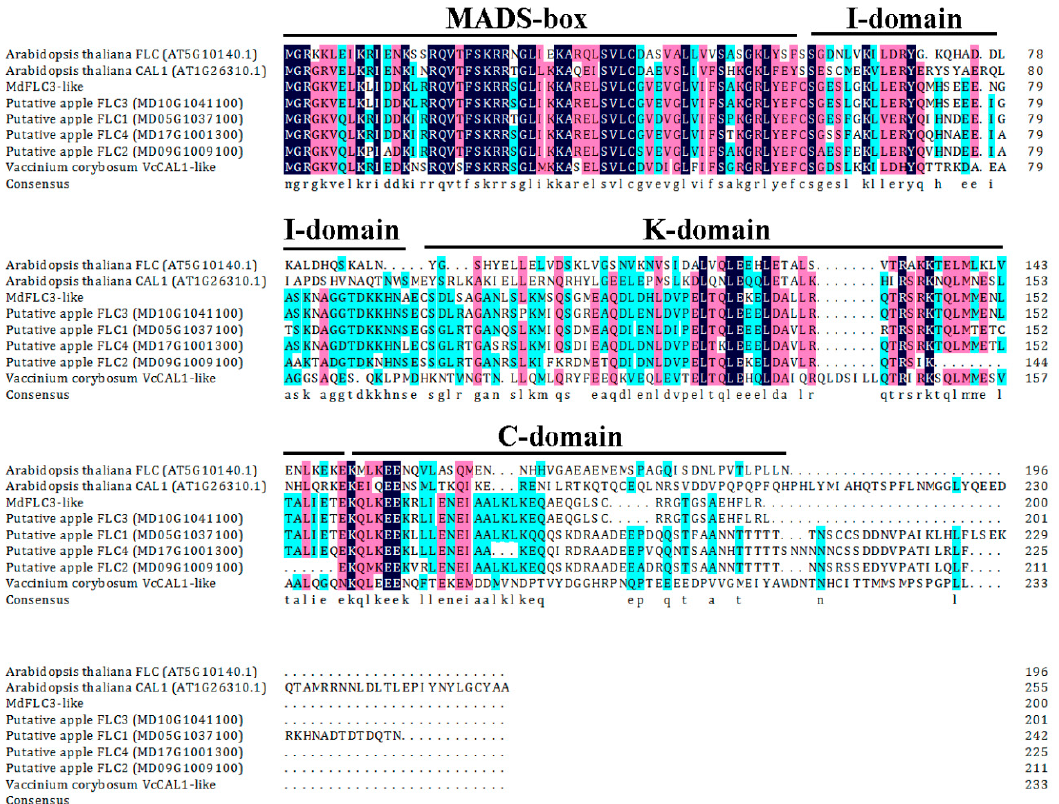
Figure 1. Alignment of Malus domestica FLOWERING LOCUS C (MdFLC3-like) (apple FLC-like ) and its orthologues in apple, blueberry, and Arabidopsis.